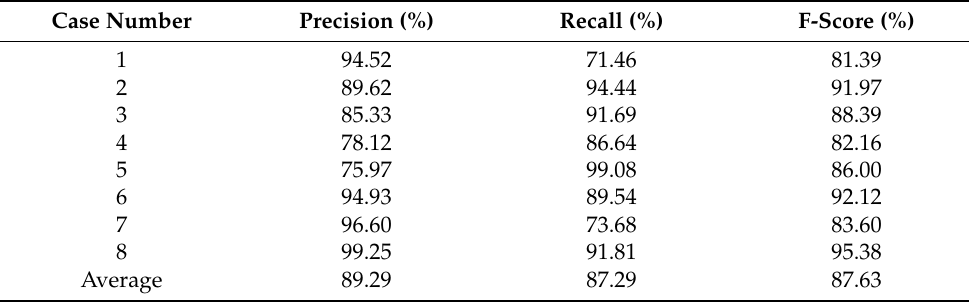
Table 2. Precision, recall, and F-score of the proposed thermal bridge detection method.